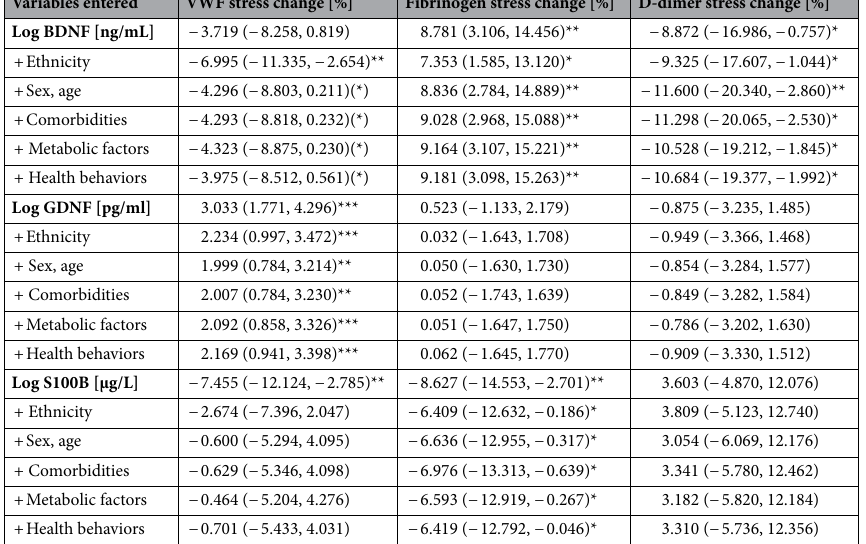
Table 4. Regression models for the associations between neurotrophins at baseline and stress-induced changes in hemostatic factors. BDNF, brain-derived neurotrophic factor; GDNF, glia cell-line derived neurotrophic factor; S100B, S100 calcium-binding protein B; VWF, von Willebrand factor. Unstandardized coefficients B (95% confidence interval) indicate the percent change from baseline in hemostatic factors with a 1-unit increase in (log) baseline levels of neurotrophins, subsequently adjusted for blocks of covariates. Significance level: (*) p < 0.10, * p < 0.05, ** p < 0.01, *** p < 0.001. Comorbidities: Human immunodeficiency virus positive status, history of atherothrombotic disease. Metabolic factors: Body mass index, hemoglobin A1c, total cholesterol to high-density lipoprotein cholesterol ratio; mean 24-h arterial pressure, estimated glomerular filtration rate, high-sensitivity C-reactive protein. Health behaviors: Current smoking, physical activity, excessive alcohol